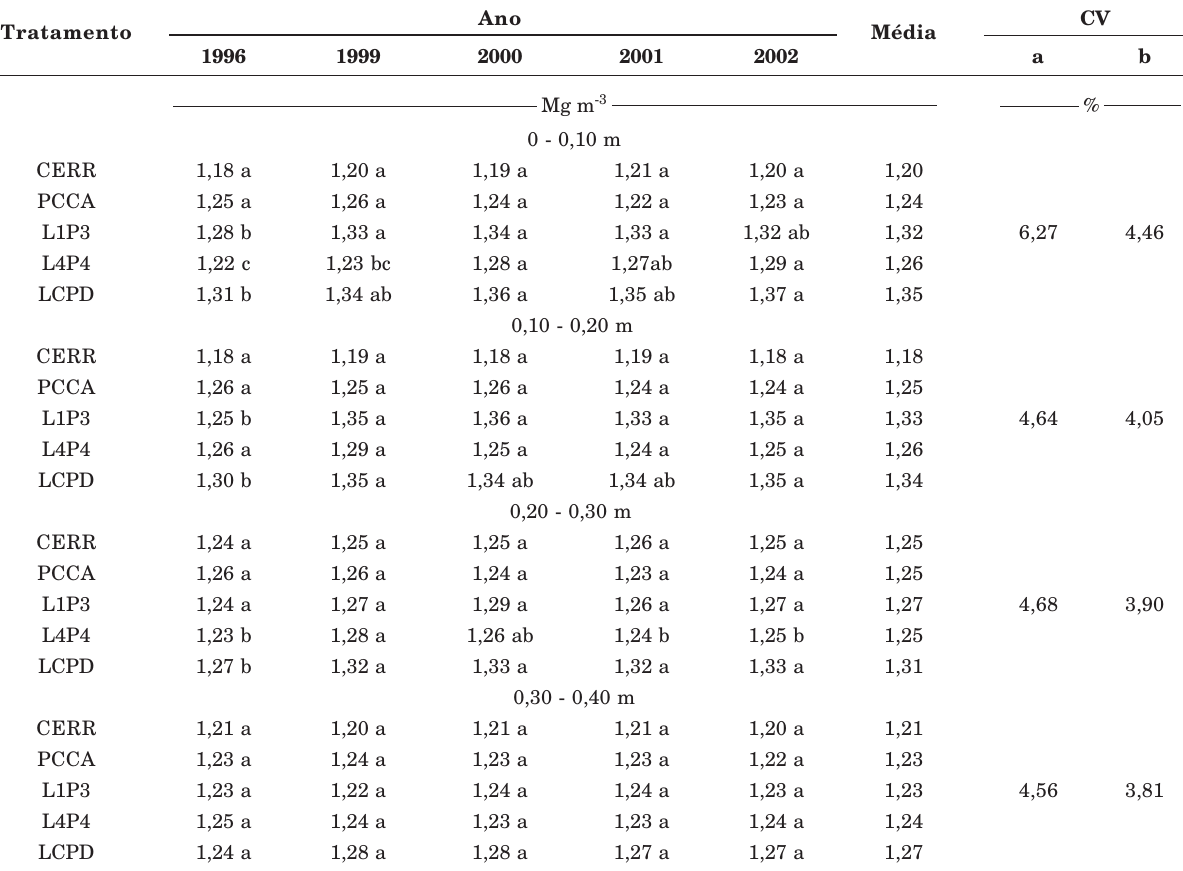
Quadro 3. Densidade do solo em diferentes sistemas de manejo, em razão dos anos e das